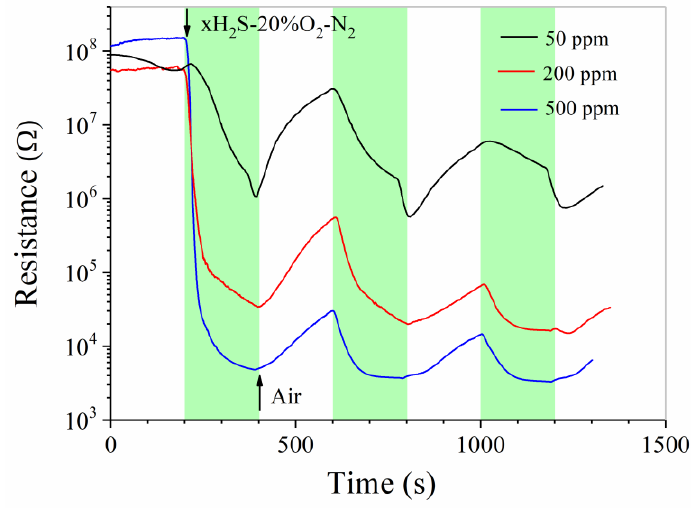
Figure 5. Responses to H 2 S at room temperature for three Pt–SnO 2 composite nanoceramic samples.